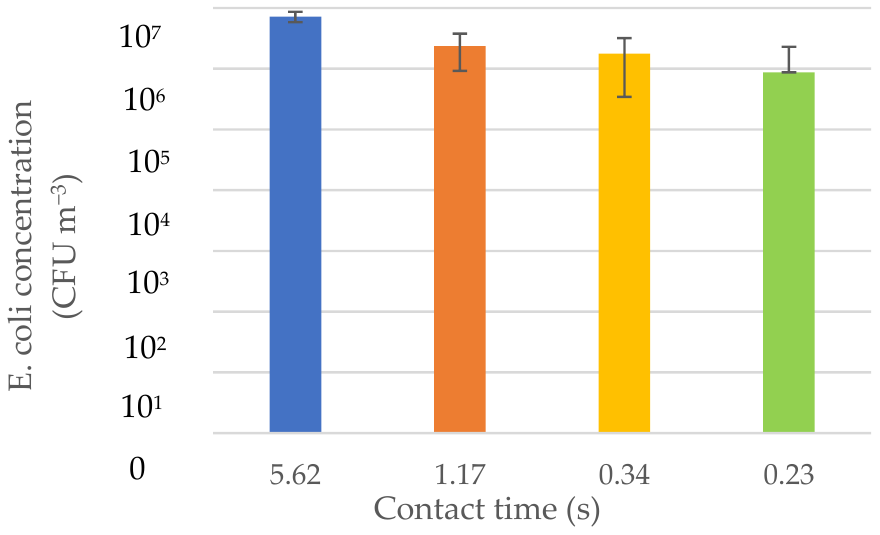
Figure 5. Contact time effect on E. coli concentration. The physical loss was calculated by comparing the concentrations (Table S1) in the upstream and downstream chambers. In this system, the physical loss of E. coli was approximately 83% or 0.8 log 10 reduction. The physical loss of the testing system is shown in Figure 6.